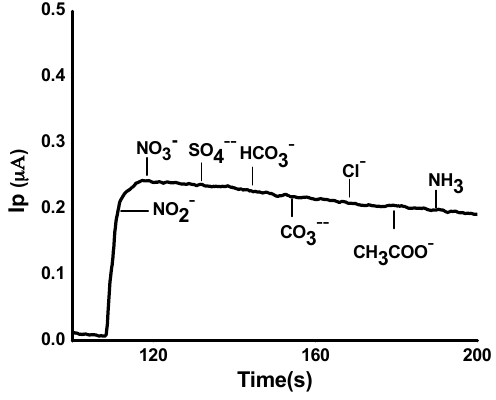
Figure 9. Amperogram showing the interference effect of 10-fold higher concentrations of interfering species on a 1 µM nitrite solution.